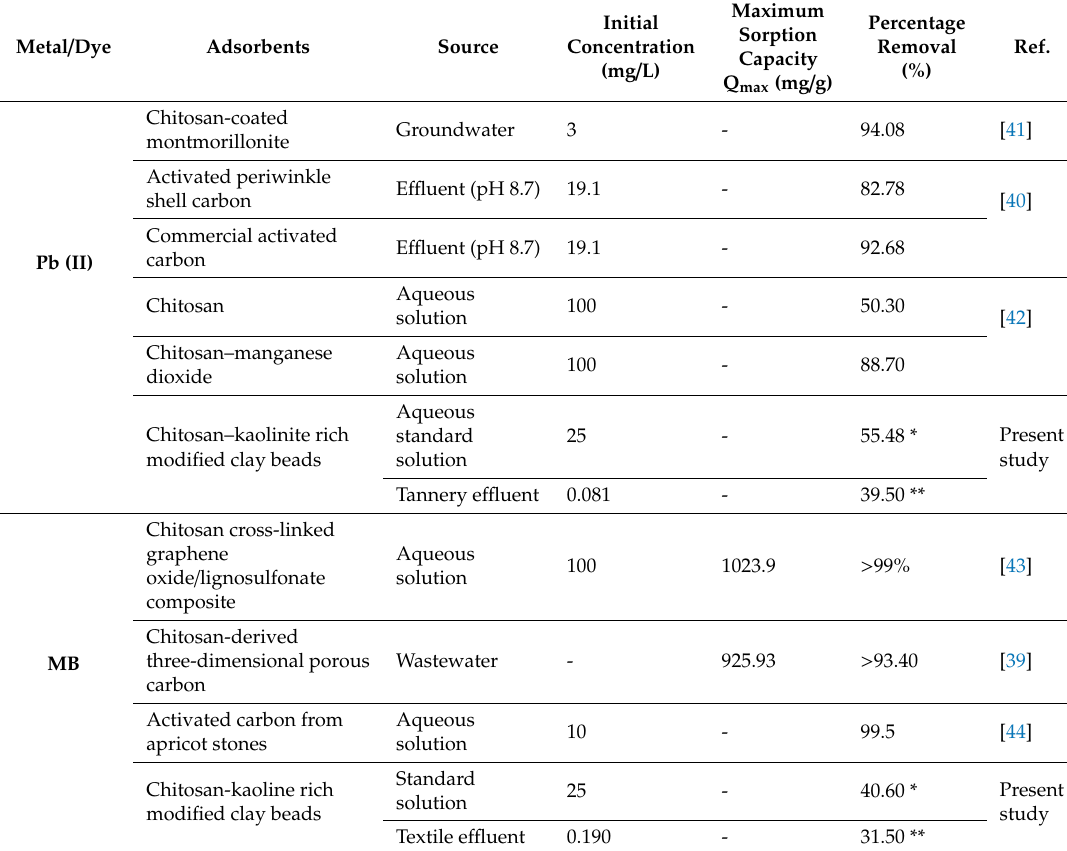
Table 5. Comparison of the Pb (II) and MB removal percentages of composite beads with other commercial